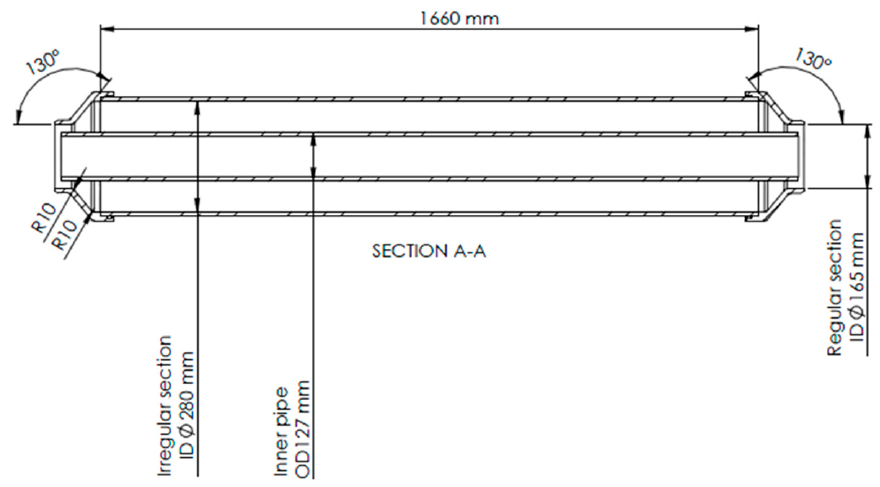
Figure 3. Details of the irregular section. Table 2. Flow rig key parameters (see Figure 2).